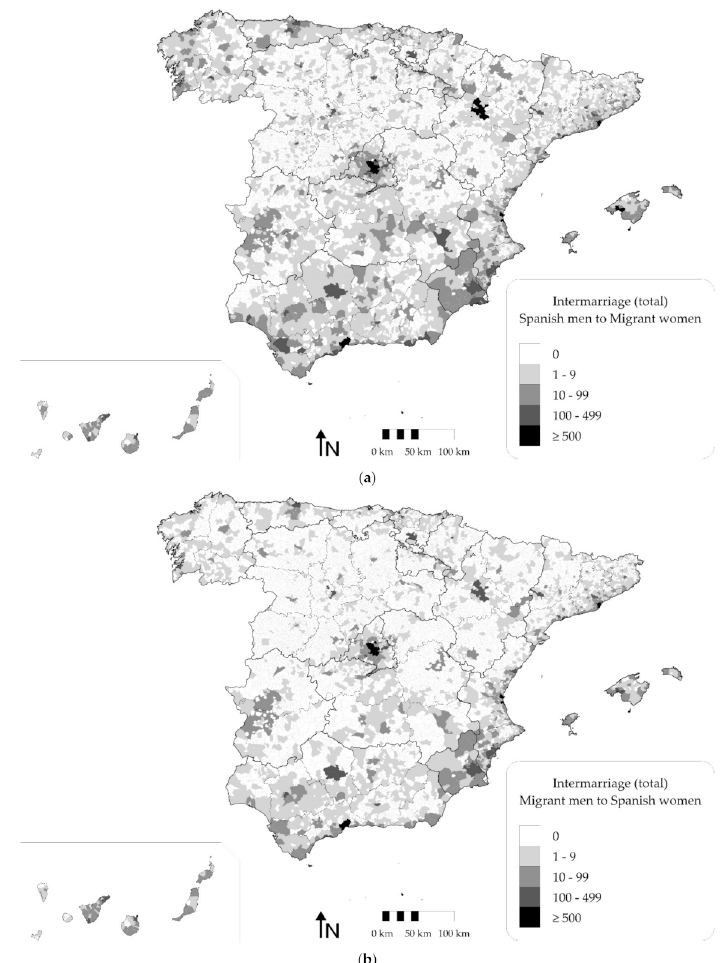
Figure 1. Spatial distribution of intermarried couples: ( a ) Spanish Men married to Migrant Women; ( b ) Spanish Women married to Migrant Men, 2005–2007. Maps were generated with the software Map Viewer, version